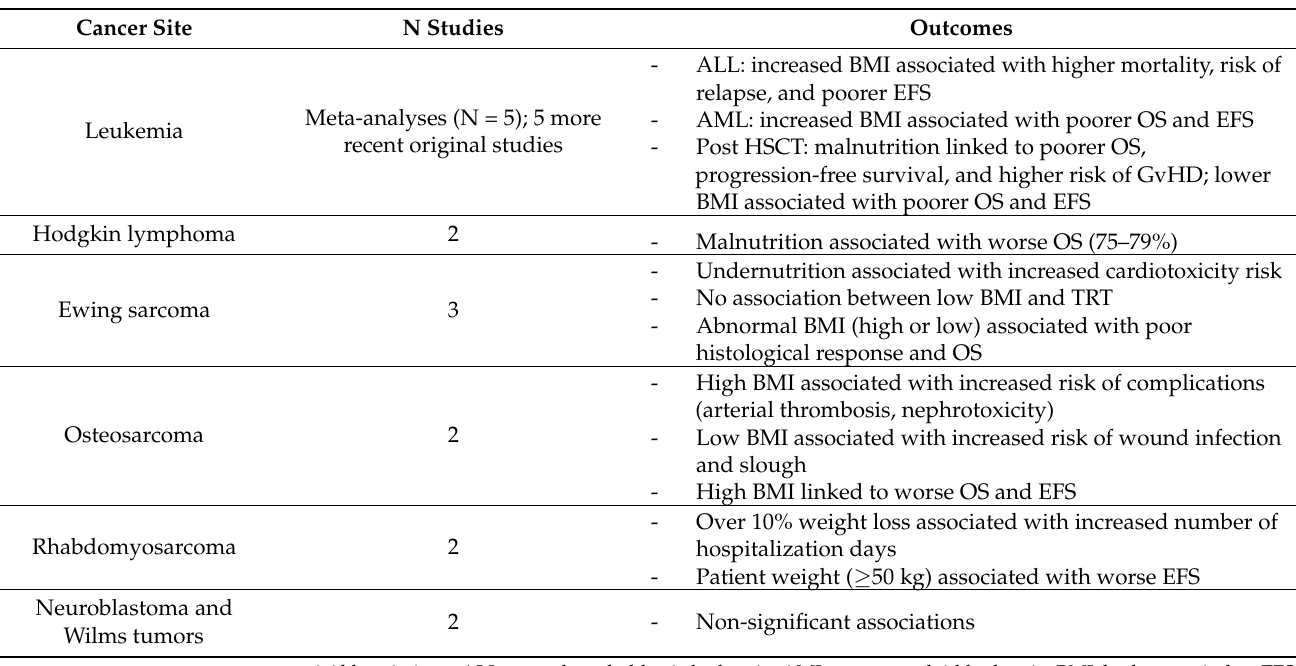
Table 1. Summary of studies reporting the association between nutritional status at diagnosis and outcomes of children with cancer